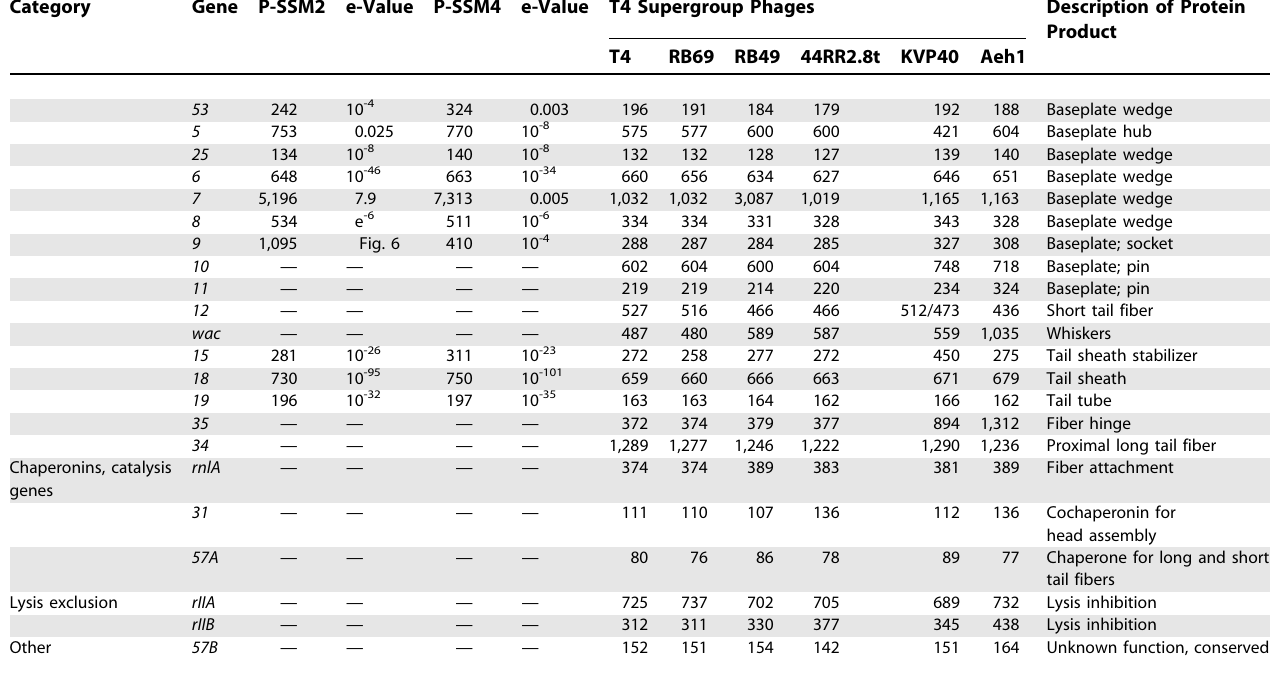
Table modified from [22,104]. The T4 supergroup is divided into T-evens (e.g., T4 and RB69), pseudo T-evens (e.g., RB49 and 44RR2.8t), Schizo T-evens (e.g., Aeh1), and the Exo T-evens (e.g., S-PM2) [106,107]. For previously published T4 supergroupphages,onlythesize(aminoacids)ofselectedpredictedcodingregionsarepresentedusinggenenamesaccordingtoT4terminology.ForP-SSM2andP-SSM4,thesizeofeachtranslatedgeneandthee-valueofthebestphage– T4-like(ormicrobe-relatedseebelow)e-valueispresented;Wherenoe-valueisgiven, theseORFswereassignedbased uponsize,domainhomology,andsynteny exceptwhere ‘‘ Fig.6 ’’ islisted,whichreferstodesignationsmadeusingtail fiber analyses summarized in Figure 6, and P-SSM2 or P-SSM4 indicates designation made through paralogy. A long dash indicates the lack of a particular gene. a The best e-value was microbe-related rather than related to T4-like phages. b The gene is split into two segments, often by an intron or homing endonuclease. c The gene is